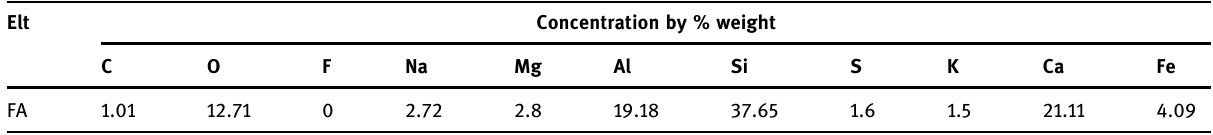
Table 2: EDS analysis of FA chemical compositions Elt Concentration by %